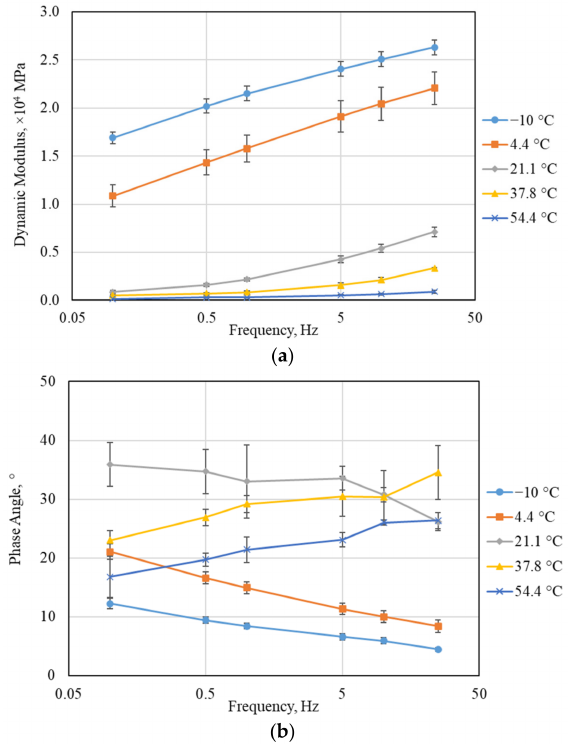
Figure 2. Dynamic modulus and phase angle from mechanical test. ( a ) Dynamic modulus; ( b ) Phase